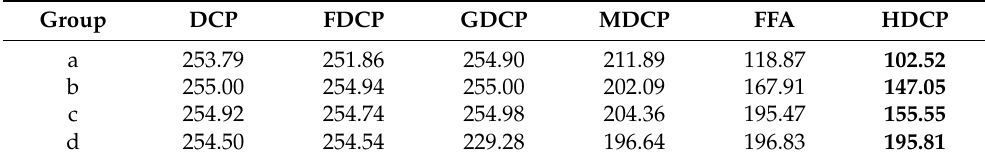
Table 1. MSE of different algorithms.